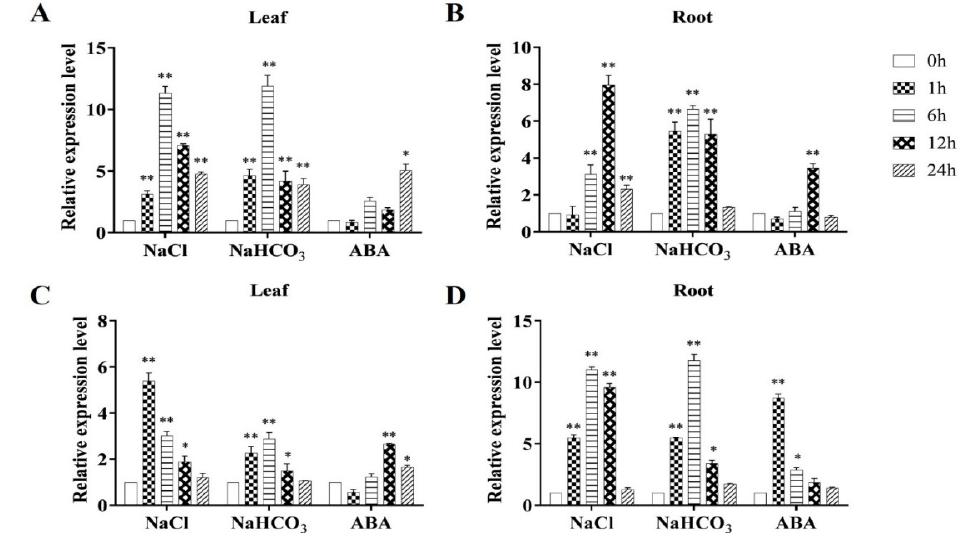
Figure 1. Relative expression of MsRCI2D ( A , B ) and MsRCI2E ( C , D ) in leaves and roots under ment. The figure on the left shows the gene expression changes in the leaves; the figure on the right shows those in the roots. The values are the means ± SDs of three replicates; * indicates a significant difference ( p < 0.05); ** indicates an extremely significant difference ( p < 0.01). ( p < 0.05); ** indicates an extremely significant difference ( p <